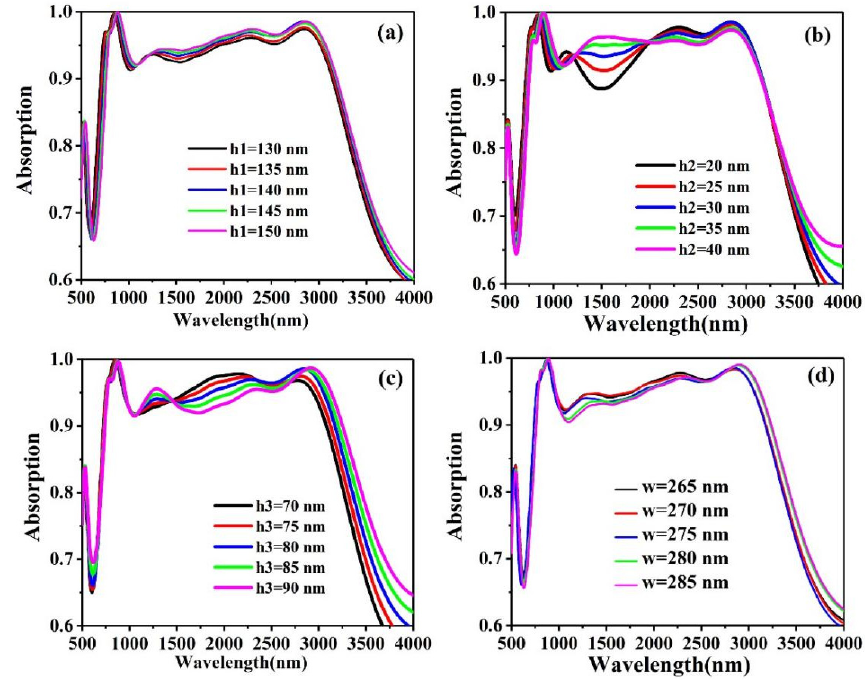
Figure 4. Comparison of absorption curves of changing ( a ) h1; ( b ) h2; ( c ) h3 and ( d ) w.